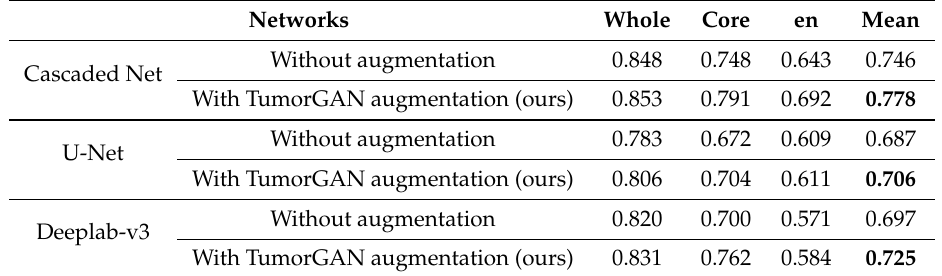
Table 3. Dice score comparison of different segmentation networks trained on “Train” and “Train + TumorGAN Augmentation”. All networks were trained without usual data augmentation techniques (e.g., flip, crop, rotation, and so on). The best mean dice scores are highlighted bold. Networks Whole